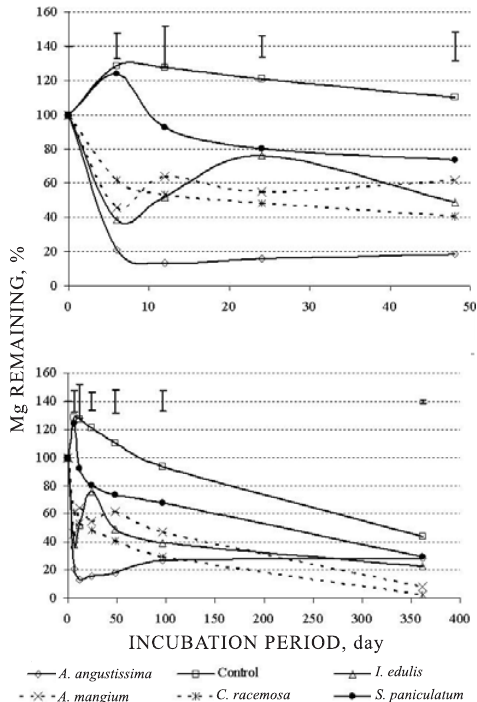
54Figure 7. Percentages of Mg remaining in mulch from different enriched legumes trees and natural fellow as control, for 48 and 362 days of incubation period. Bars represent LSD with p <